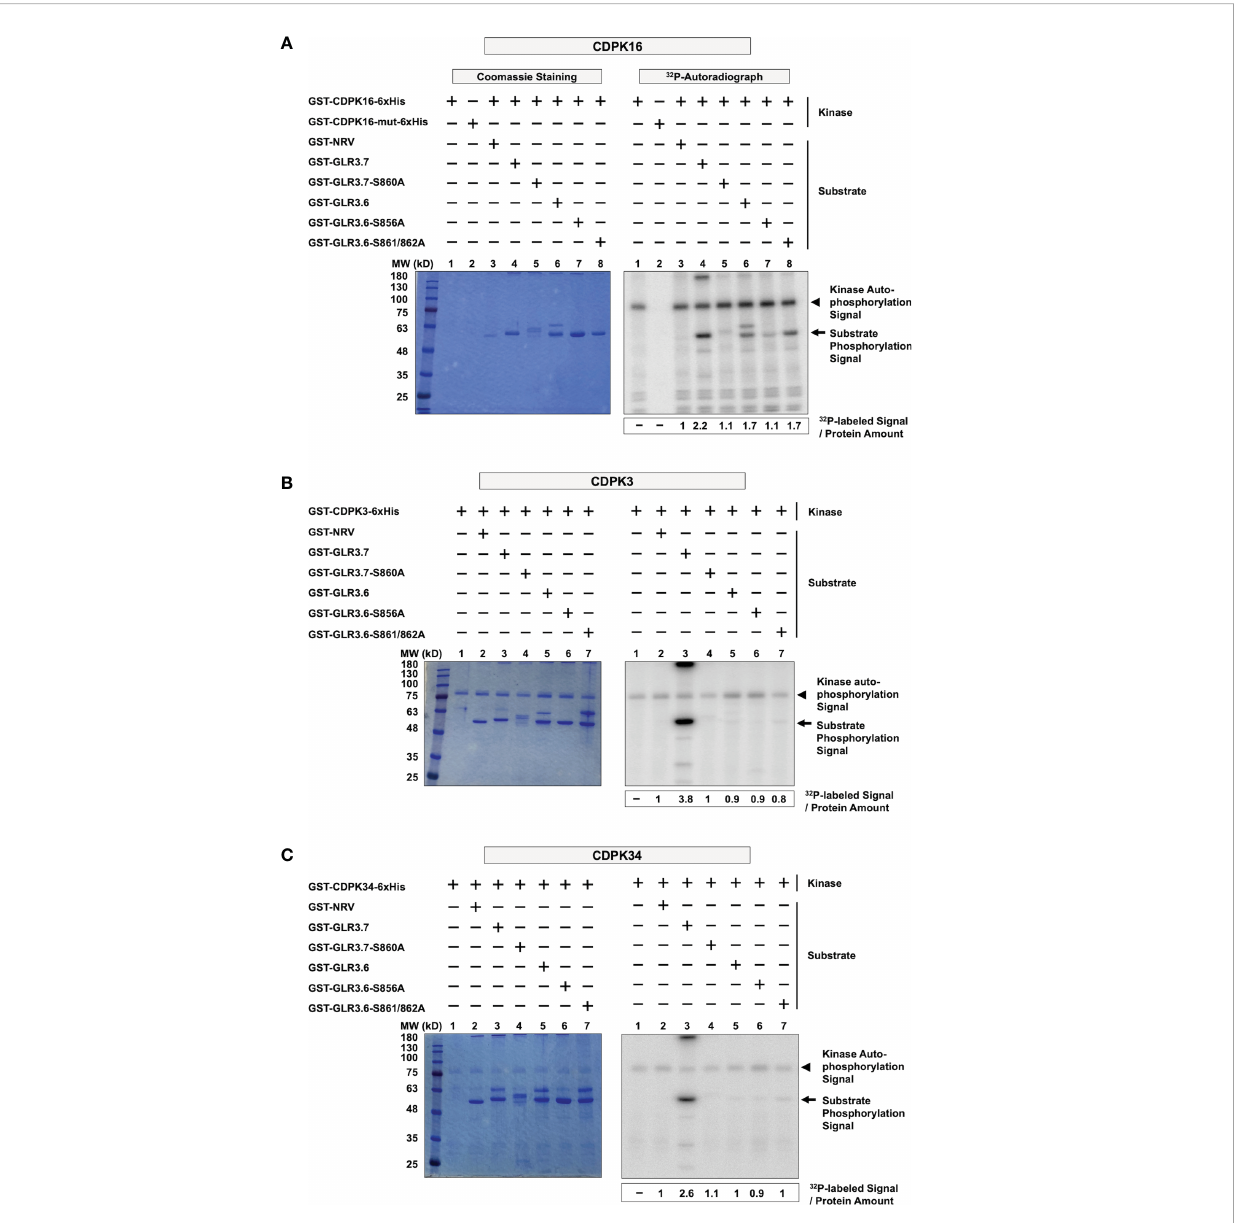
FIGURE 3 CDPK16 speci fi cally phosphorylates Ser856 of GLR3.6, but CDPK3 and CDPK34 did not. (A – C) Recombinant kinases GST-CDPK16-6xHis, GST-CDPK3- 6xHis, and GST-CDPK34-6xHis were used to perform the kinase assays in vitro . Substrates of the GST-fused peptides GST-GLR3.6, GST-GLR3.6-S856A, and GST-GLR3.6-S861/862A were analyzed. GST-GLR3.7 and GST-GLR3.7-S860A were used as positive and negative control, respectively. GST-NRV was used as a GST tag control. Coomassie blue-staining gels show the protein input (Left panels), and the corresponding 32 P-labeled autoradiograms (Right panels) are shown. The autophosphorylation signals of CDPK16, CDPK3, and CDPK34 (approximately 100 kD, 85 kD, and 85 kD, respectively), are visualized and are marked with arrowheads. The substrate phosphorylation signals are marked with arrows. The speci fi c 32 P-labeling intensity was calculated based on g - 32 P-labeled signals normalized to the band intensity of input with CBB